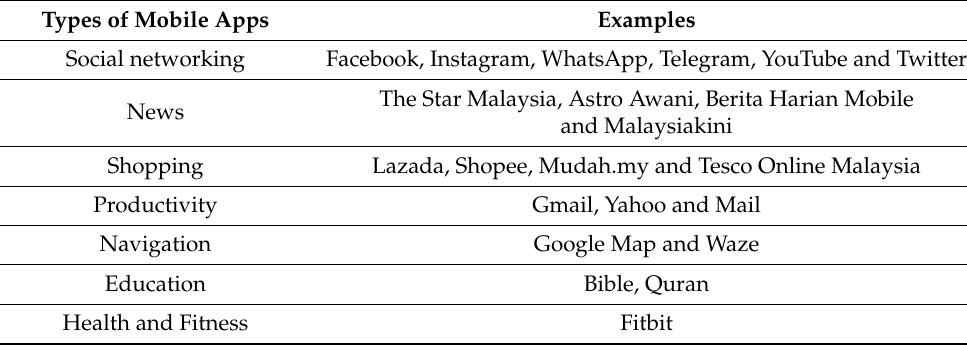
Table 2. The common types of mobile apps used by the